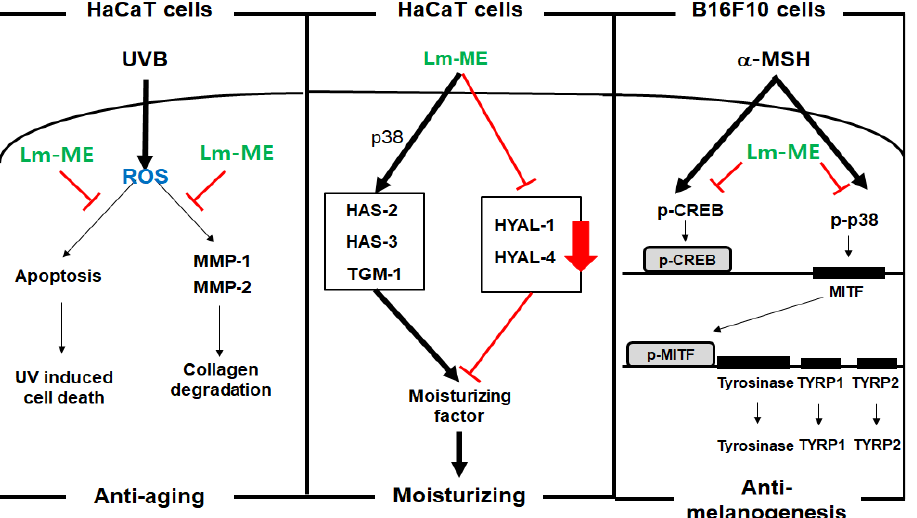
Figure 5. Schematic summary of the skin protective actions of Lm-ME with UV protection, moisturizing, anti-melanogenesis properties.